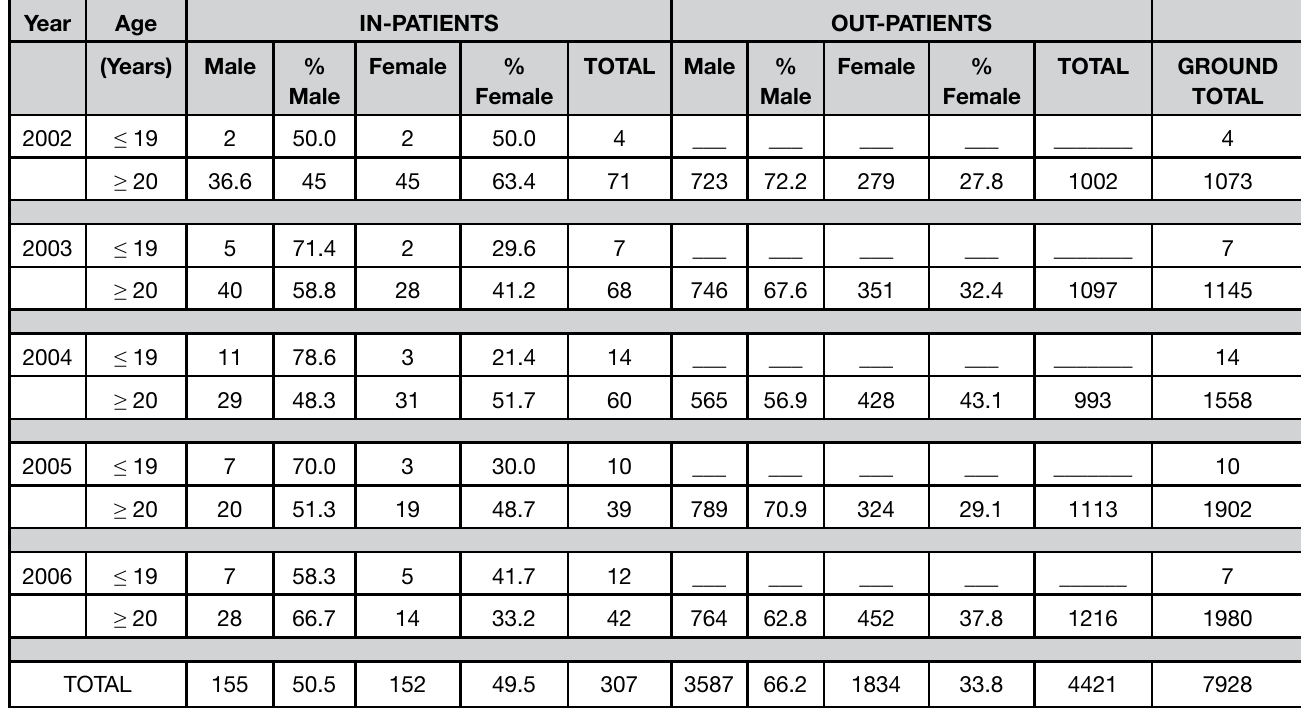
Table 1: In-Patient and Out-Patient Attendance for Physiotherapy Services between January 2002 and December 2006 Year Age IN-PATIENTS